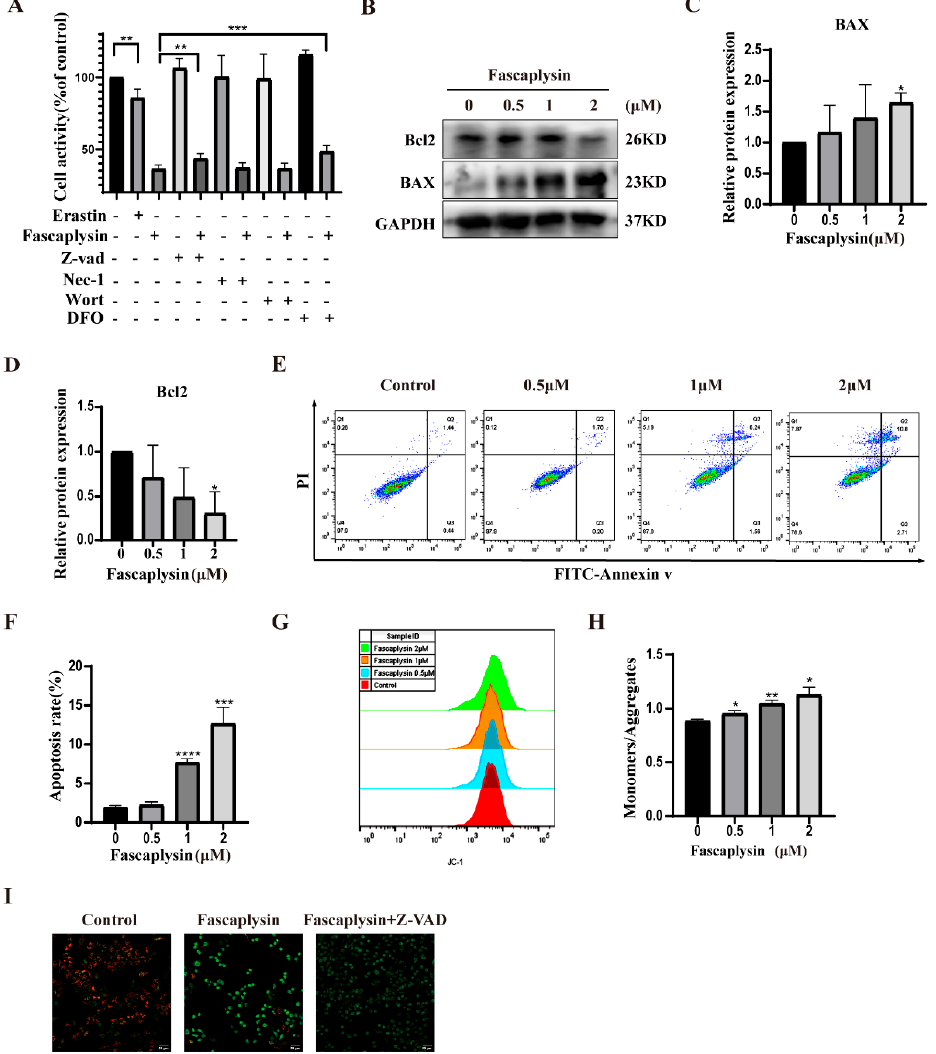
Figure 3. Fascaplysin induced apoptosis in A549 cells. ( A ) A549 cells were treated with erastin (10 μ M), fascaplysin (2 μ M), and cell death inhibitors Nec-1 (10 μ M), DFO (50 μ M), Z-VAD (10 μ M), and Wort (5 μ M), alone or in combination, for 3 h. Cell viability was measured by CCK8 assay. ( B – D ) BAX and Bcl2 protein expression were detected by Western blotting. ( E , F ) Apoptosis of fascaplysin-treated A549 cells was analyzed using flow cytometry. The histogram shows quantitative analysis of total percentage of early and late apoptotic rates. ( G – H ) We used JC-1 probe to examine the effect of fascaplysin on MMP in A549 cells by flow cytometry. The histogram is a statistical chart of the ratio of monomers to aggregates. ( I ) MMP was measured by confocal microscopy after treatment of A549 cells with fascaplysin (2 μ M) alone or in combination with Z-VAD (10 μ M). Analysis results represent mean ± SD, * p < 0.05, ** p < 0.01, *** p < 0.001, and **** p < 0.0001.